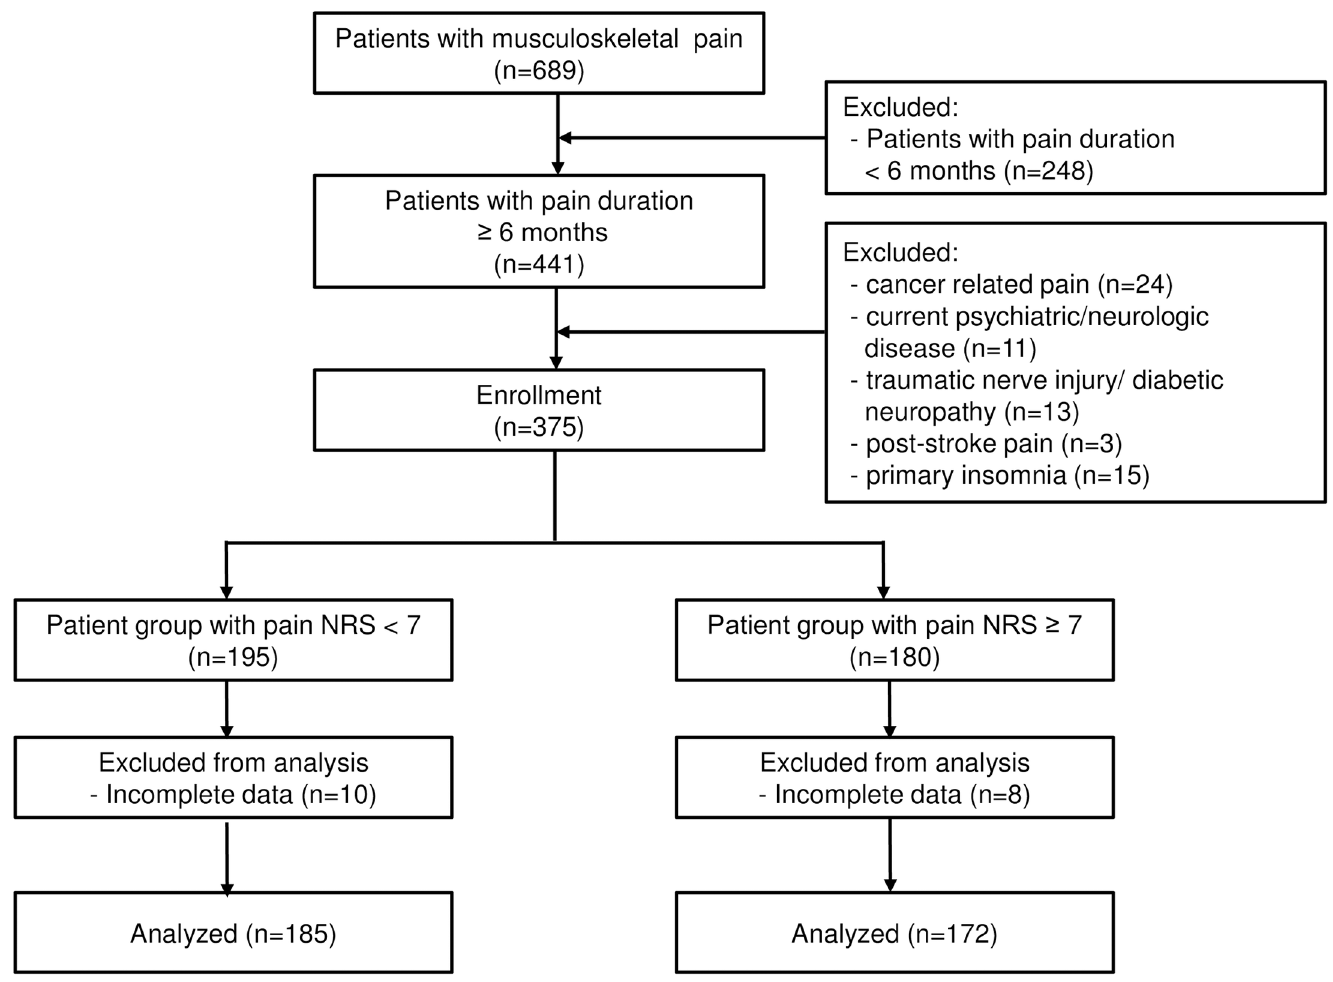
Fig 1. Flow diagram of the study. NRS = numeric rating